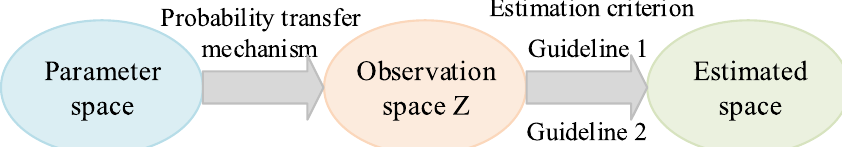
Fig. 6 Statistical model of parameter estimation